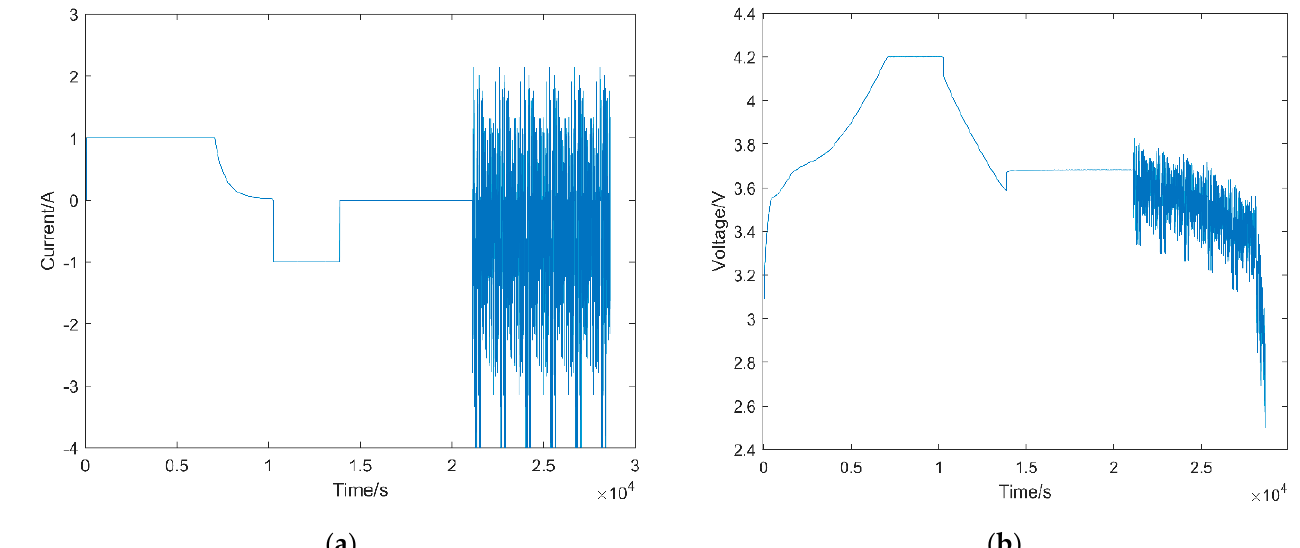
Table 1. Main specifications of different batteries.